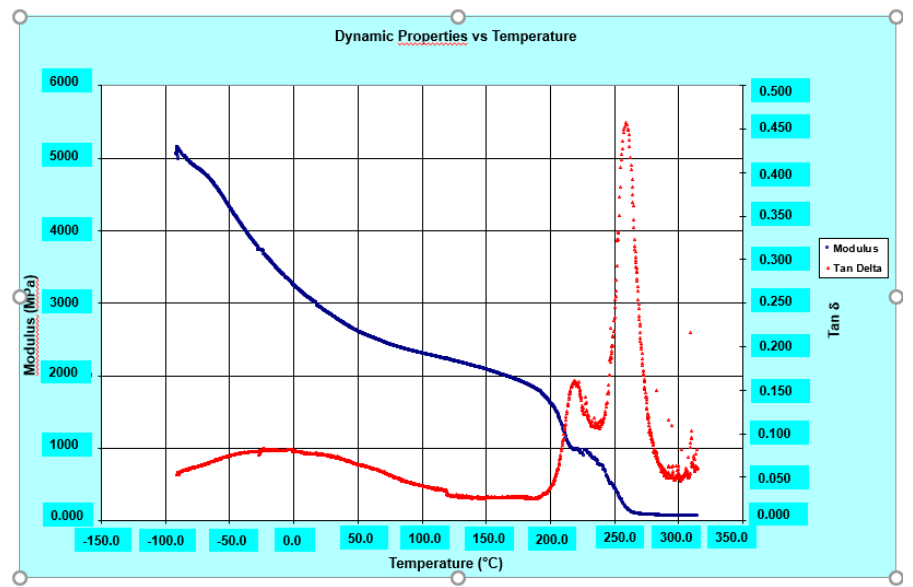
Figure 12. Loss factor (tan δ ) and Storage modulus of the R0.5%G nanocomposite.